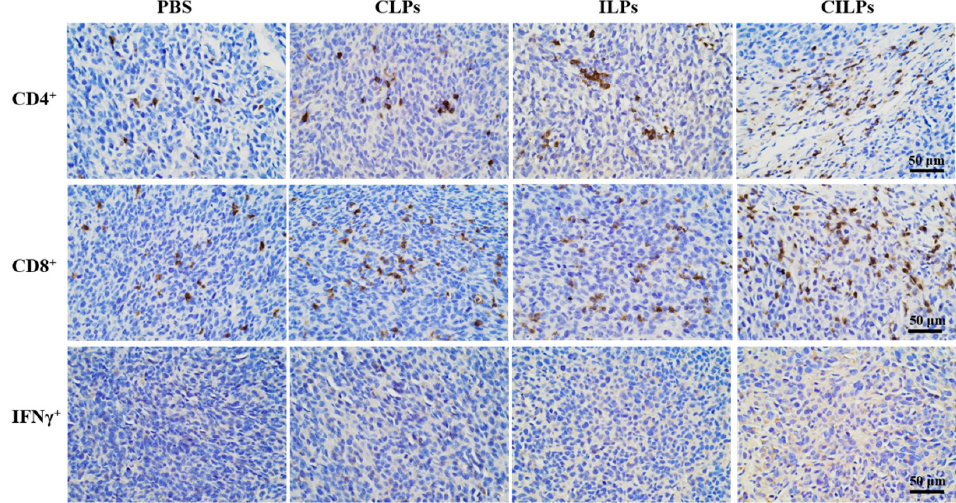
Figure 7. Immunohistochemistry of mouse tumor tissues; positive cells are stained brown. Scale bar, 50 µm ( n = 5).